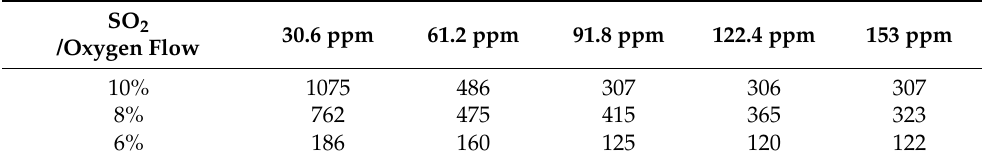
Figure 8. Sensing transients to SO 2 for samples with ( a ) 6%, ( b ) 8%, ( c ) 10% oxygen flow ratio at 300 °C; ( d ) the sensing response of three different oxygen ratios. Table 1. Gas-sensing performance (%) of 6%, 8%, 10% samples (300 °C) as a function of sulfur dioxide (SO 2 ) concentration.